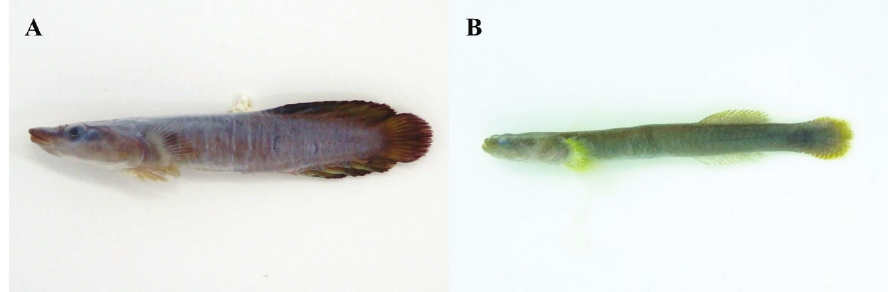
Figure 10. A Lepadichthys frenatus , MFD-318, 47.5 mm SL B Luciogobius guttatus , MFD-144, 50.2 mm SL.